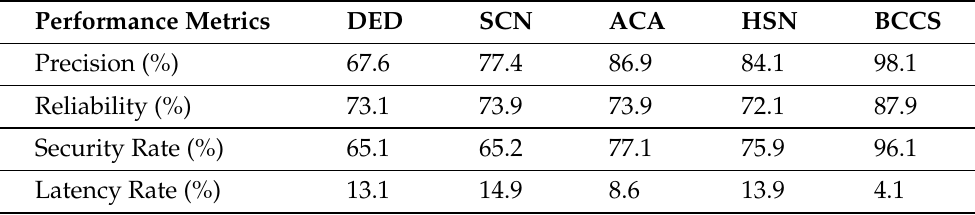
Table 1. Experimental results for user